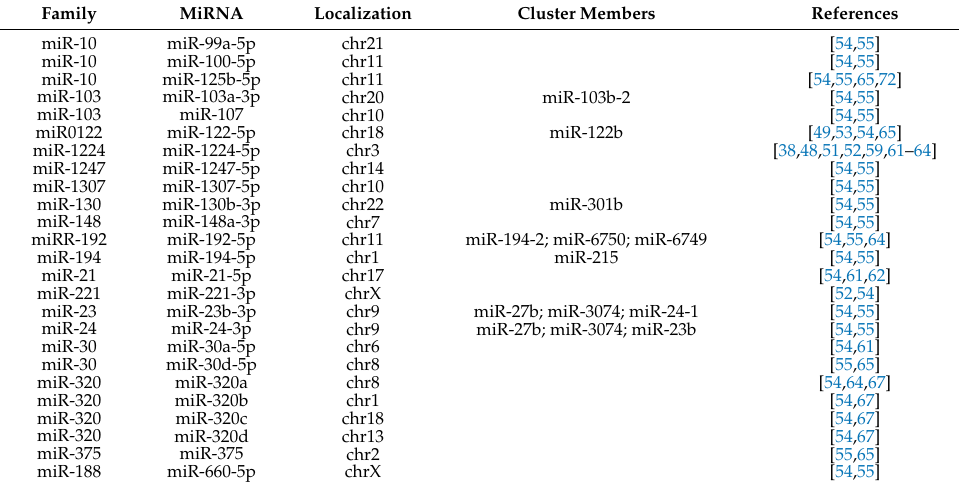
Table 3. Characteristics of miRNAs reported in at least two independent publications carried on ALF